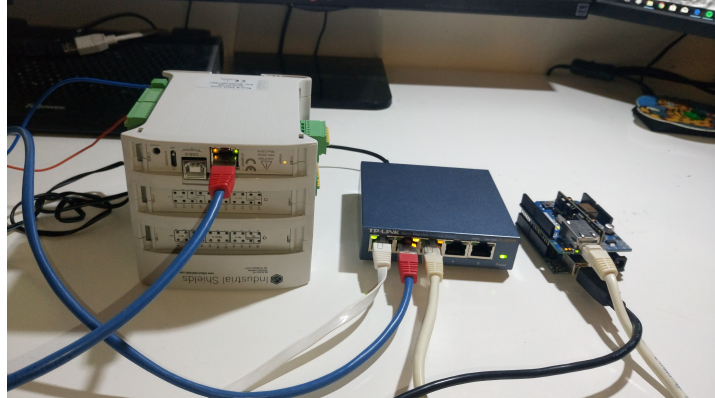
Figure 6. A view of the hardware devices managed in the case